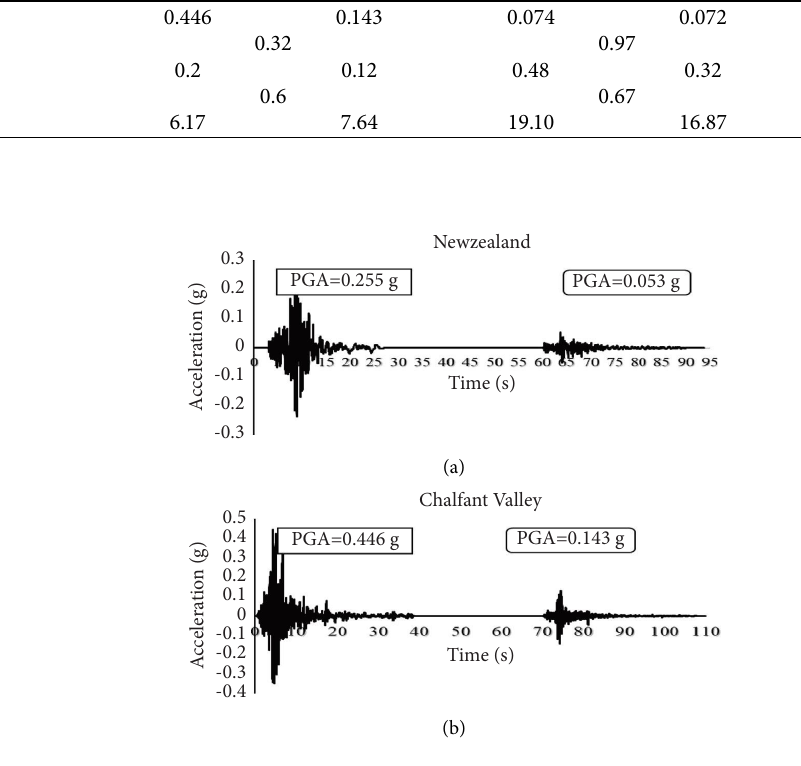
Figure 8: SS records with maximum EPA: (a) New Zealand accelerometer. (b) Chalfant Valley